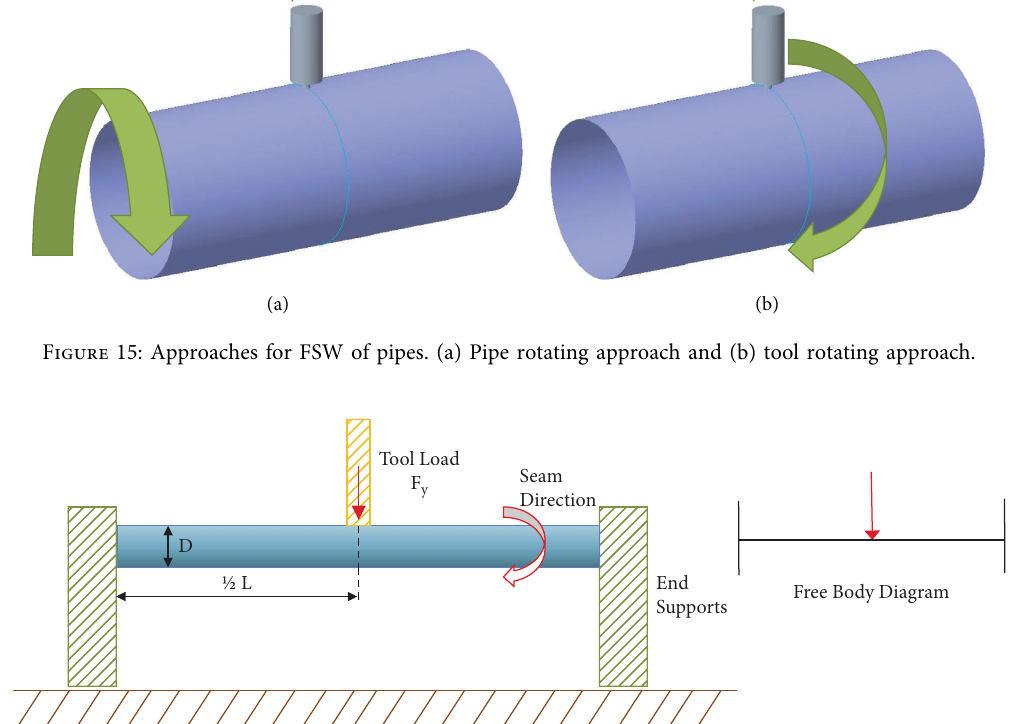
Figure 16: Pipe fxture–perceived structure with forces